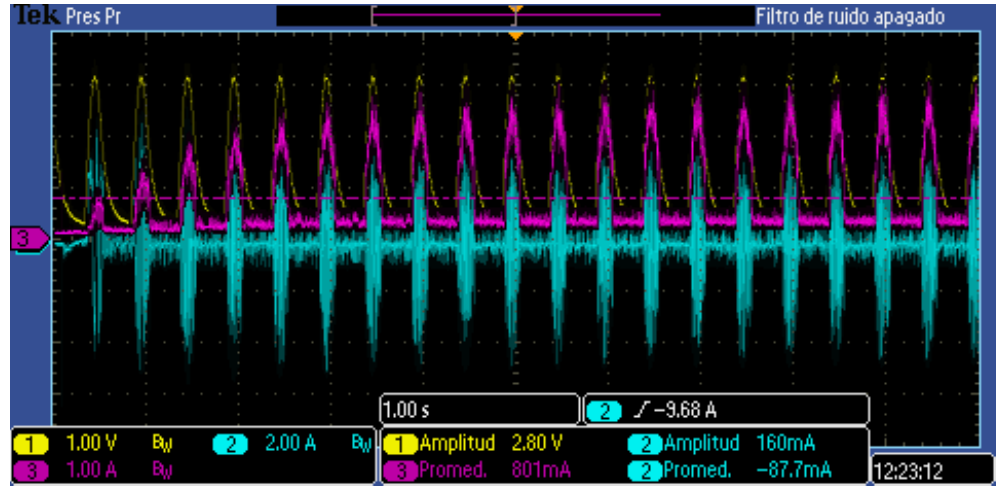
Figure 18. Transient response of the controller. Electronics 2018 , 7 , x FOR PEER REVIEW